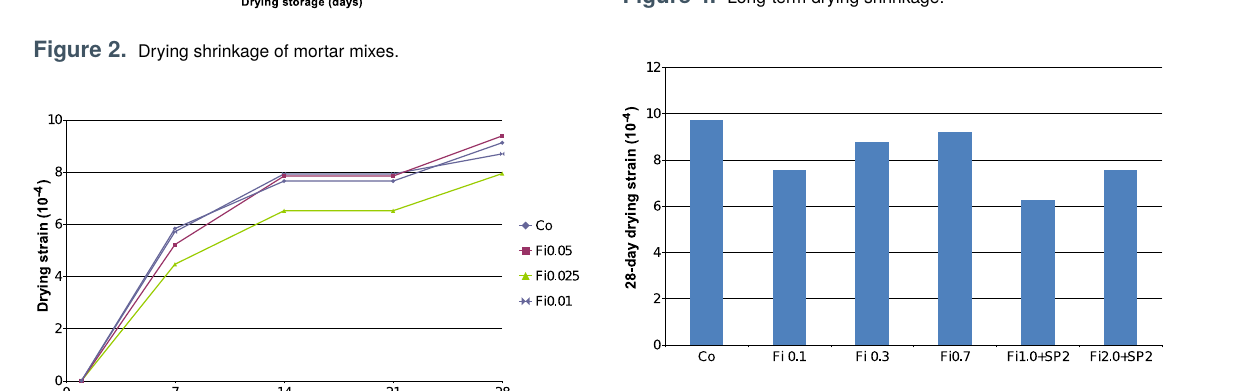
Figure 5. 28-day drying